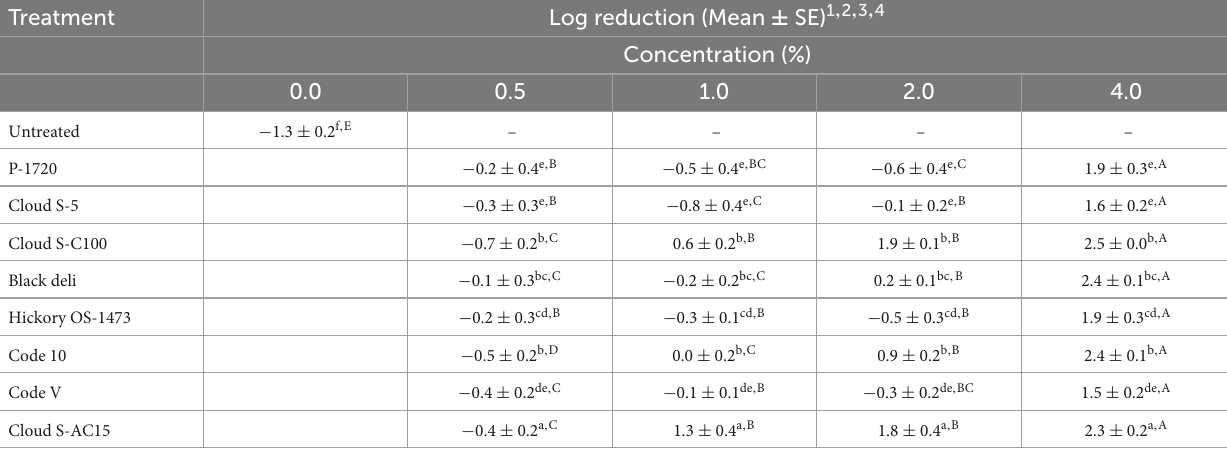
TABLE 6 Mean logarithmic reduction (between day 0 and day 35) of Aspergillus flavus counts in semi-moist pet food treatments with inclusion of liquid smoke preparations at 0.5, 1, 2, and 4% concentrations in comparison with untreated (0% smoke) over 35 days incubation period. Treatment